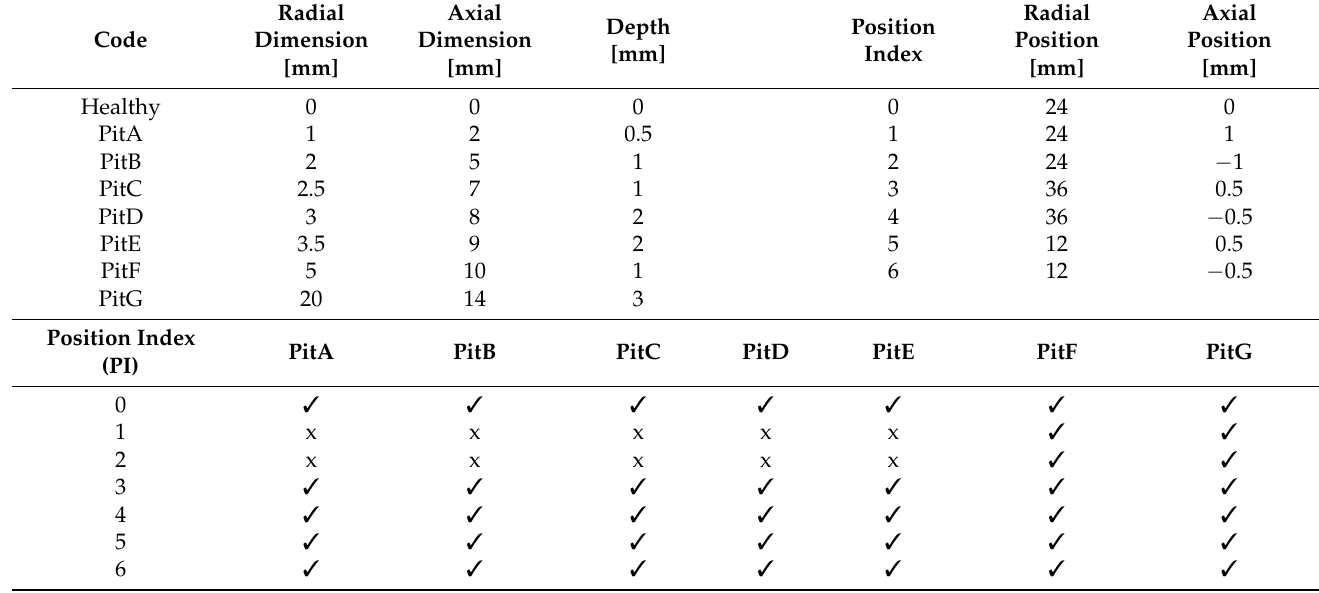
Table 1. Simulated pit parameters, positions indexes, and simulations performed.